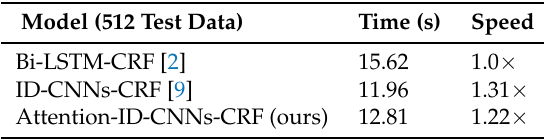
Table 5. Comparison of the test